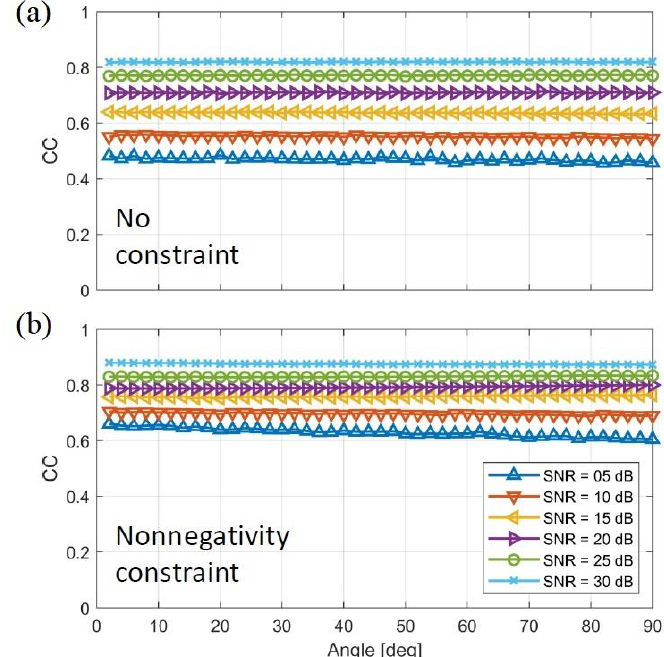
Figure 4. Simulation result for correlation coefficient evaluation on different particle phase responses, the x-axis denotes the phase difference between the simulated particle responses. ( a ) shows the correlation coefficient with no constraint applied and ( b ) with nonnegativity constraint.